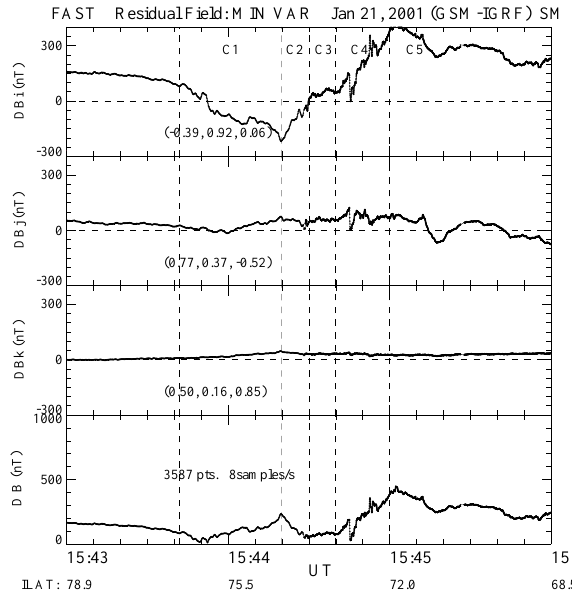
Fig. 10. The 8 sample/s magnetic field at FAST presented in min- imum variance coordinates. The axes coordinates thus derived are shown in an SM system in each panel. The vertical lines bracket dif- ferent currents from the different gradients in the ∼ east-west com- ponent (top panel): into the ionosphere when the gradient is nega- tive; out of the ionosphere when the gradient is